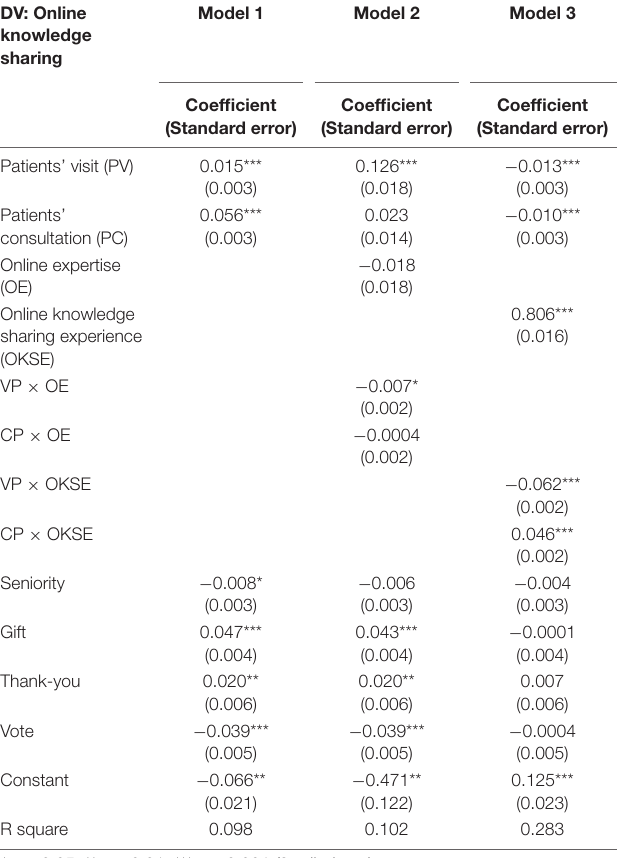
TABLE 4 | Results of robust